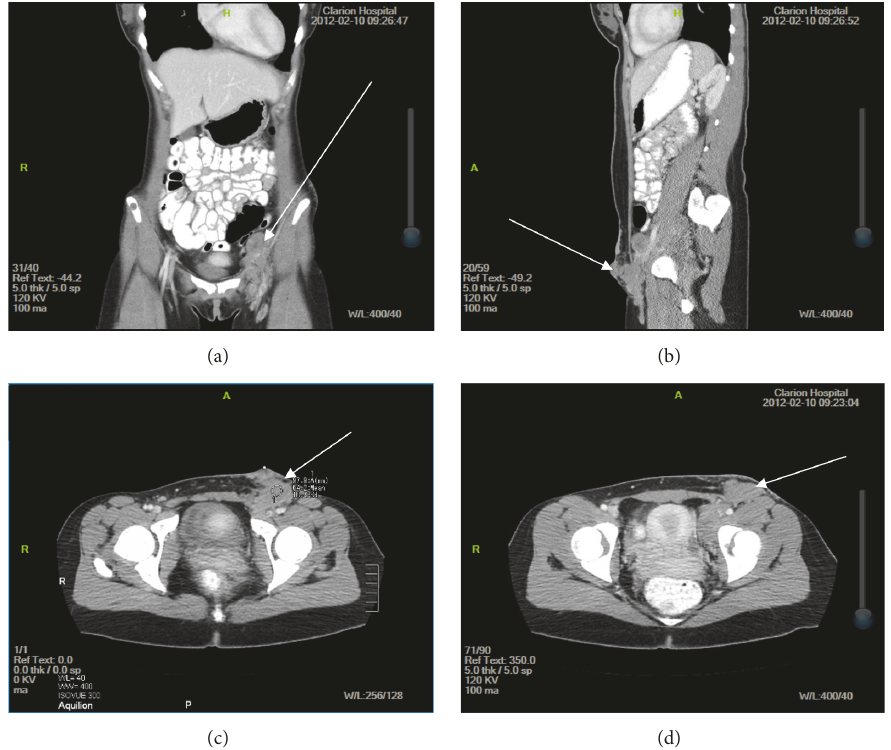
Figure 2: Initial CT imaging of the abdomen and pelvis with and without contrast for evaluation of the inguinal mass in (a) coronal, (b) sagittal, and (c) axial views demonstrating superficial extension and involvement of anterior abdominal wall by mass and (d) axial view demonstrating a proximal cross-sectional view of the mass that is not extending to the superficial